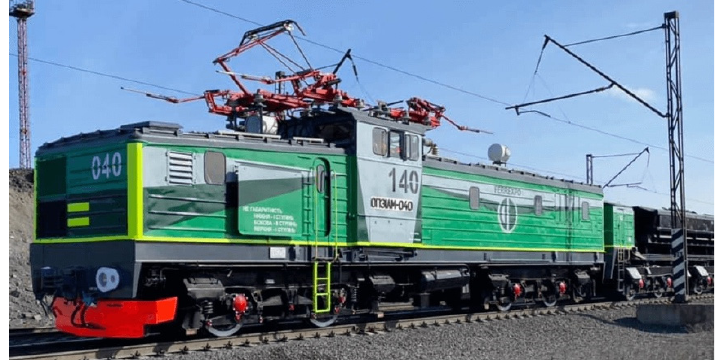
Figure 1. OPE1AM traction unit № 040 (photograph taken by the authors) [2].